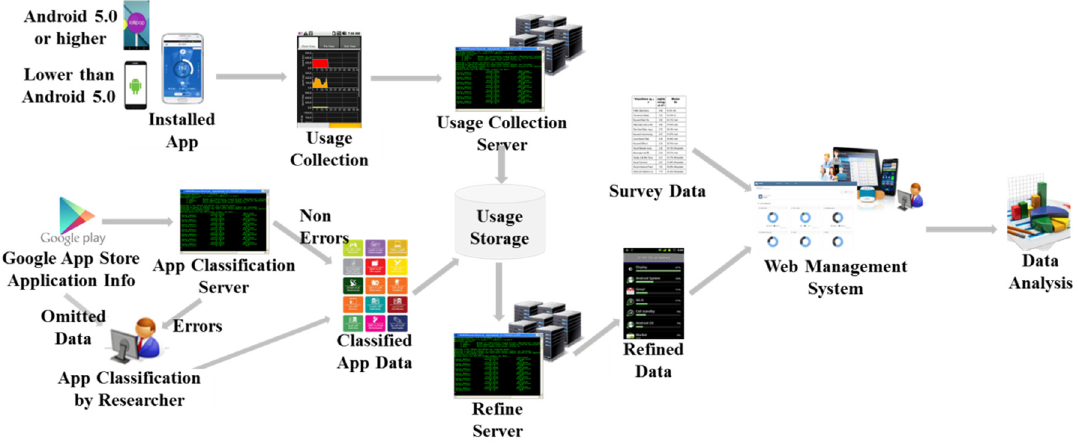
Figure 3. System architecture of sensing and monitoring app.